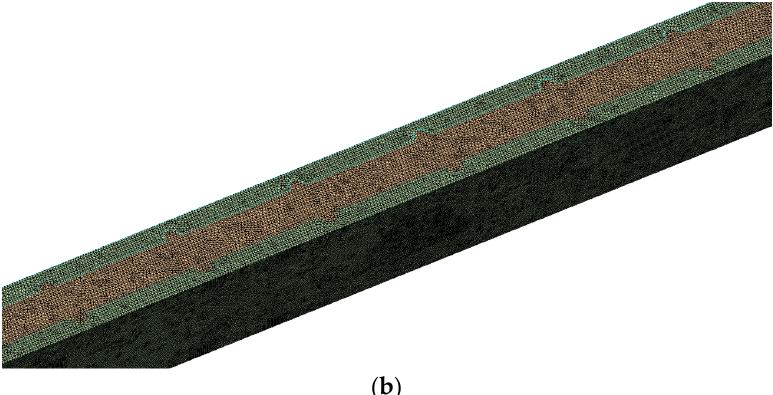
Figure 3. Meshing of fluid and MCHS domain: ( a ) enlarged view, ( b ) isometric view. Table 4. Grid independent test.